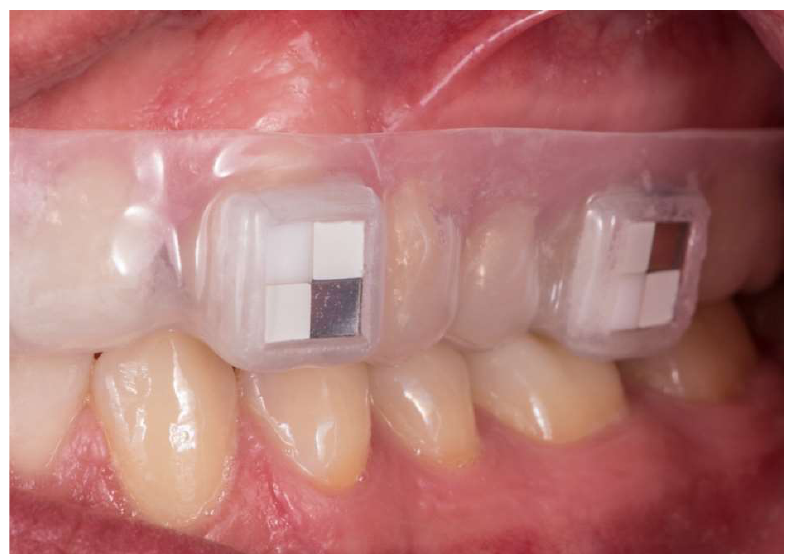
Figure 5. Individual splint in situ with two split specimens on the canine and first molar of the left side of the upper jaw.